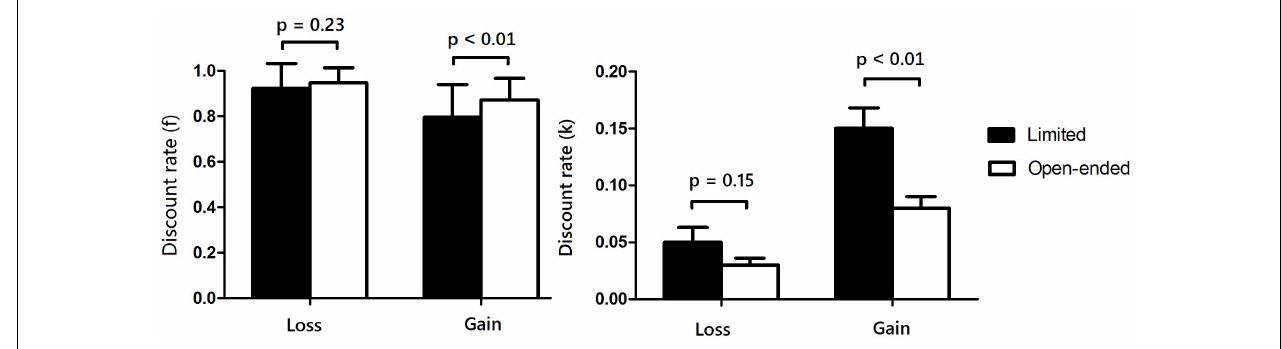
FIGURE 2 | Discount rates of intertemporal choices for gains and losses under limited vs. open-ended FTP